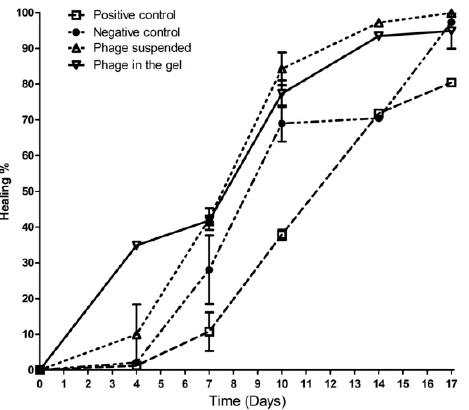
Figure 7. The wound healing percentage from day 0 to the 17th day in the four groups.